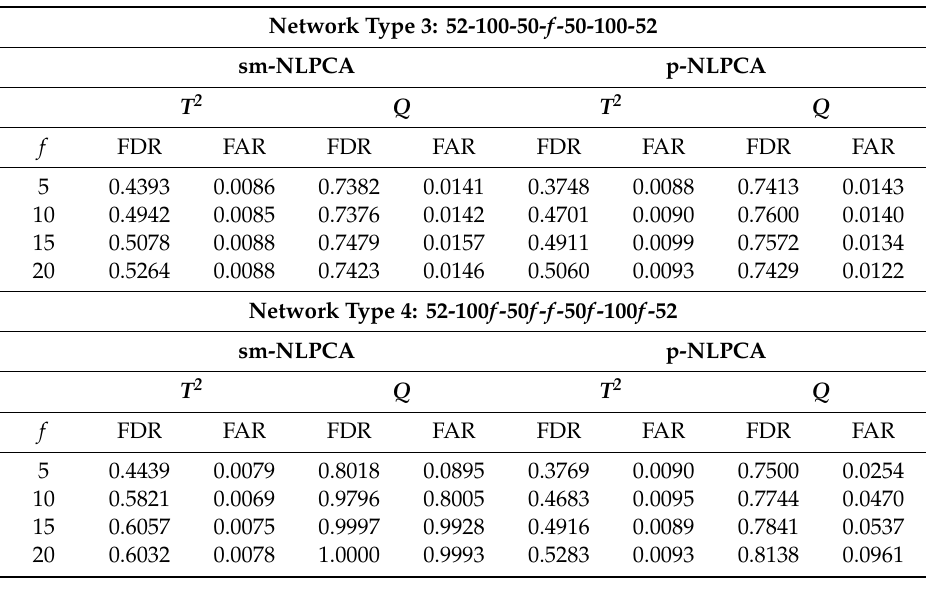
Table 5. Process monitoring results with varying the neural network size (with seven